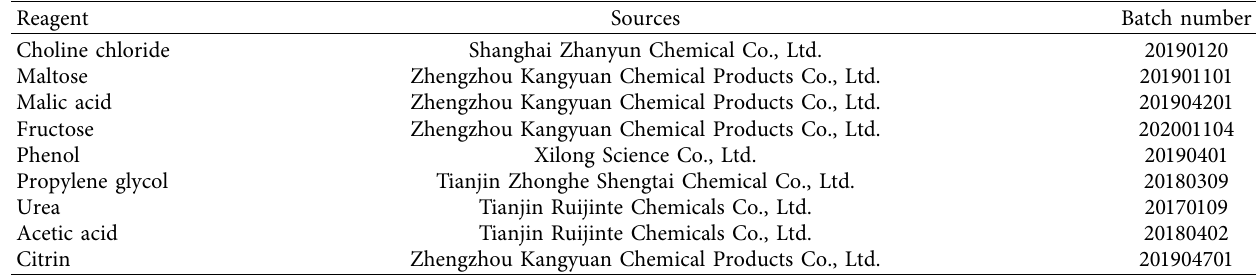
Table 2: Sources of deep eutectic